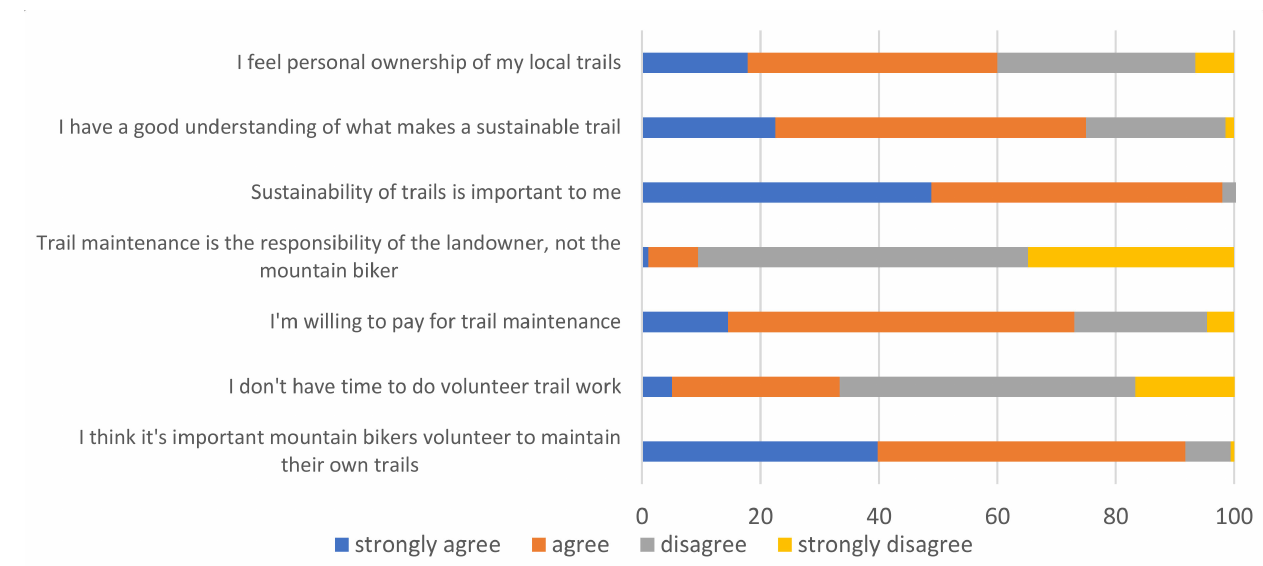
Figure 5. Attitudes towards trail maintenance and